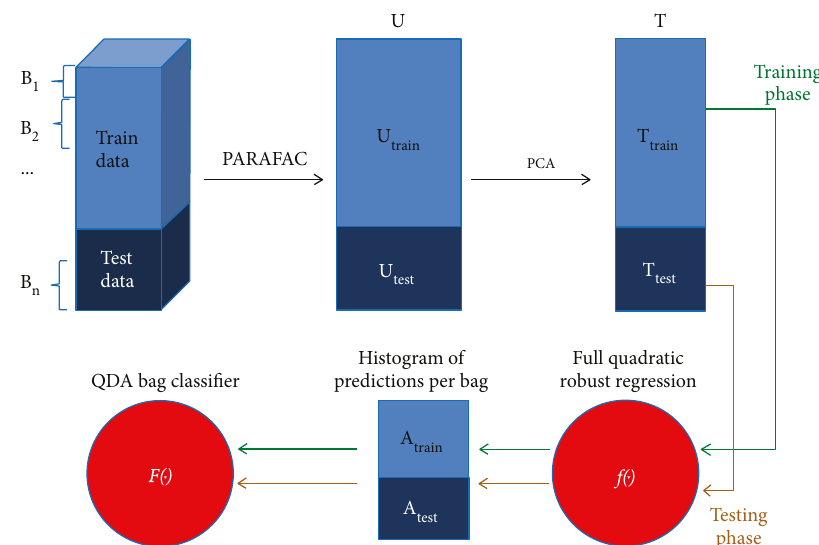
Figure 2: The architecture of TensMIL, where U is the feature matrix extracted from the raw data by PARAFAC decomposition, T is the score matrix obtained by performing PCA on U, A is the matrix containing the bag-level features, f ˑ is the full quadratic regression model, and F ̇ ˑ is the QDA classi fi